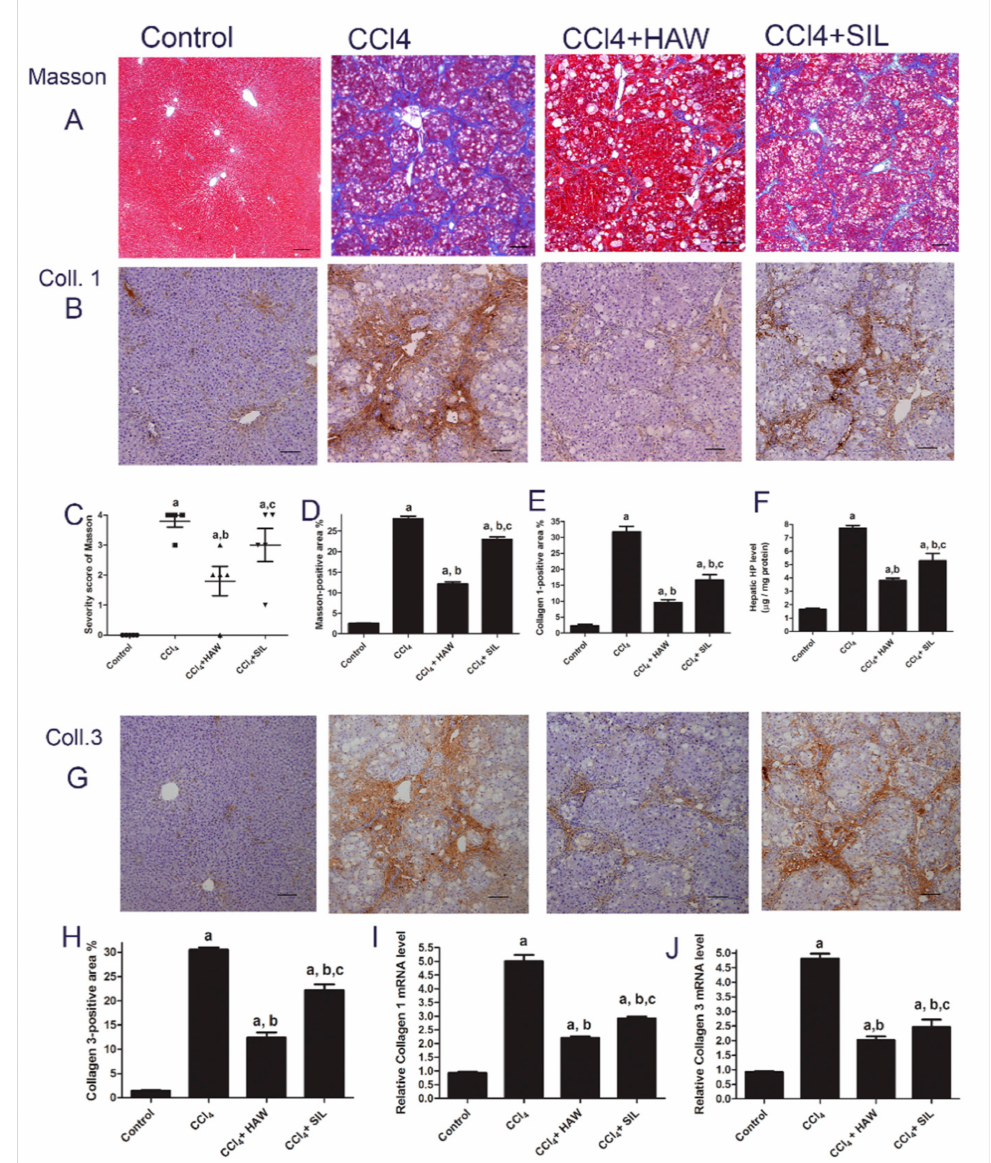
Figure 2. E ff ects of HAW on the CCl4-induced liver fibrosis rat model. ( A ) representative images of Masson staining (blue area) staining, 100 × magnification, scale bar equals 200 µ m. ( B ) Representative images of immunohistochemically expression of collagen-1 (brown area). Scale bar equals 100 µ m, ( C ) severity score of Masson, and ( D ) Masson-positive area expression as a percentage of the total area ( n = 5 per group) using the free software NIH ImageJ. ( E ) collagen-1 expression area as a percentage of the total area ( n = 6 per group). ( F ) hydroxyproline (HP) level in the liver. ( G ) representative images of immunohistochemically expression of collagen-3 in the liver (brown area) scale bar equals 100 µ m. ( H ) collagen-3 expression area as a percentage of the total area ( n = 3 per group). ( I , J ) Analysis of type 1 and 3 collagen mRNA expression in the liver by quantitative RT-PCR ( n = 3 per group). Results were normalized to glyceraldehyde 3-phosphate dehydrogenase (GAPDH) mRNA. Data are presented as means ± SEM ( n = 6 in each group). a is p < 0.05 vs. control group, b is p < 0.05 vs. CCl4 group, and c is p < 0.05 vs. HAW